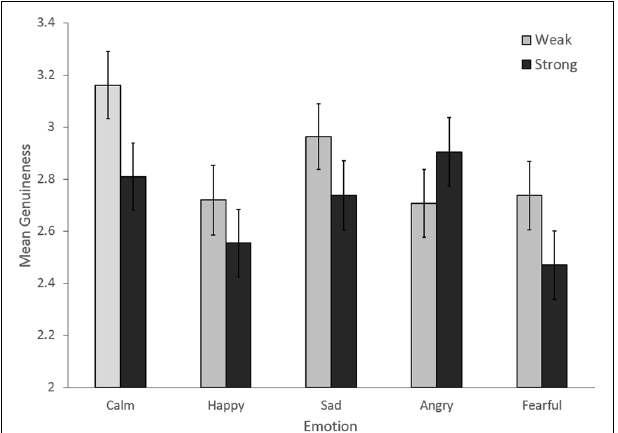
FIGURE 2 | Mean genuineness ratings showing the Emotion by Intensity interaction in Experiment 2. Error bars denote the standard error of the means.